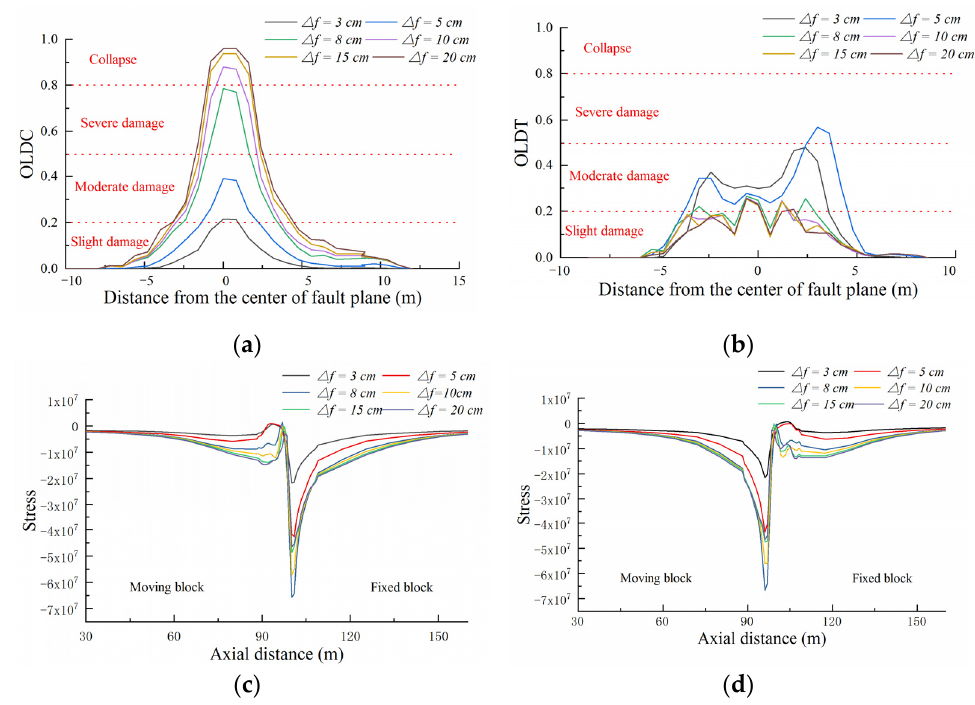
Figure 6. Overall concrete lining damage under different fault displacements ( β = 60 ◦ ; Stiff) and axial stress curve of concrete vault and invert ( a ) OLDC, ( b ) OLDT, ( c ) vault and ( d ) invert.